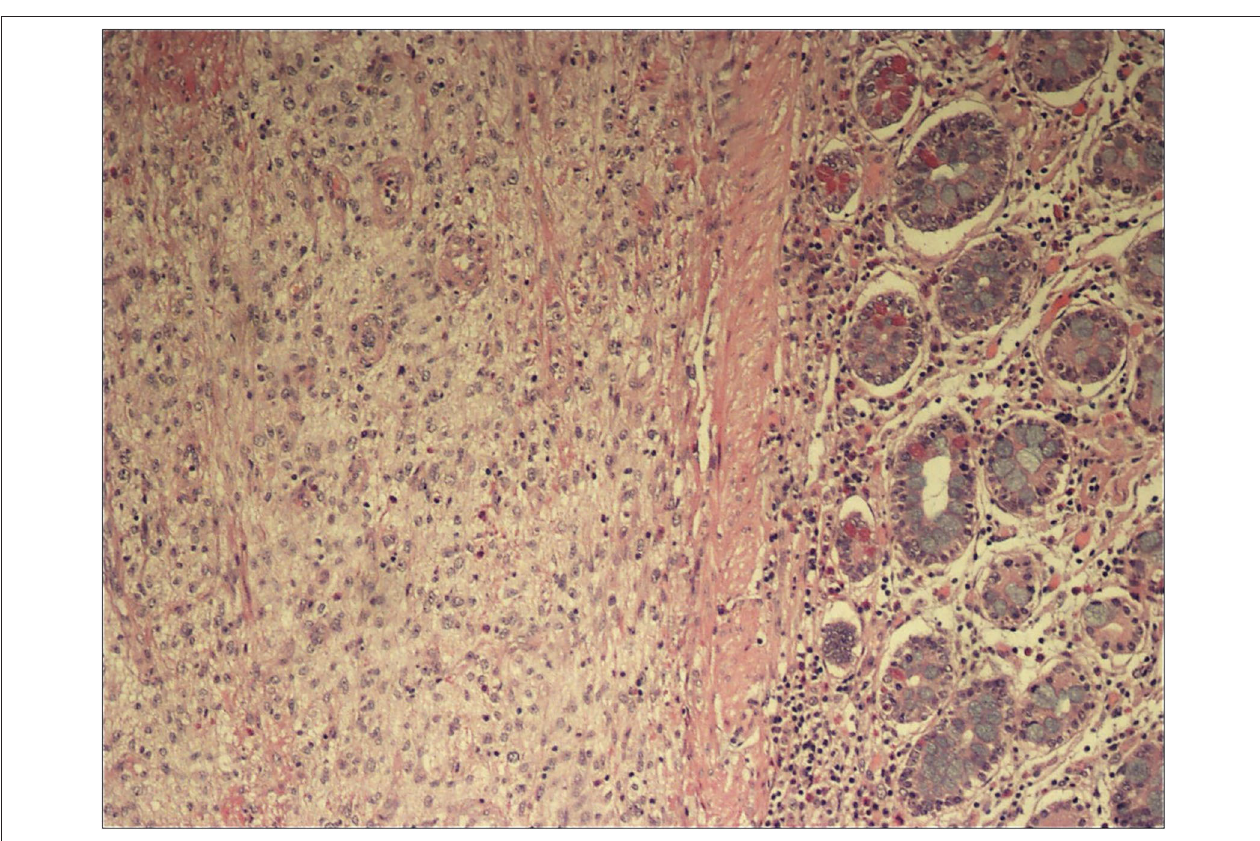
FIGURE 2 | H&E, 100x magnification: Ileal submucosal spindle cell